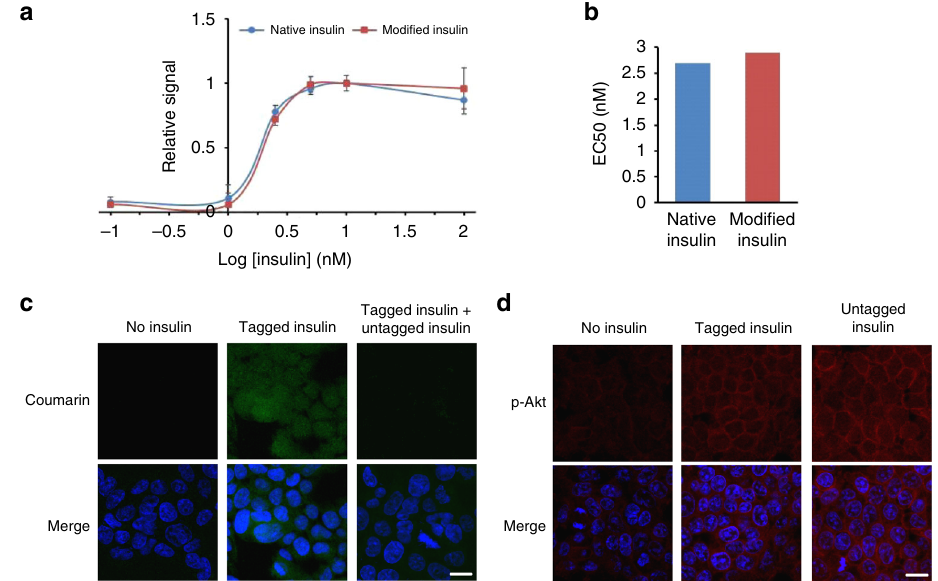
Fig. 5 Insulin bioactivity assay. a , Bioactivity measurement for native and modi fi ed insulin in a dose-dependent pAkt cell-based assay. The error bar represents standard error of mean (SEM). The assays were repeated at least three times ( n = 3). b EC50 value determination from ( a ), absolute values obtained by extrapolation of graphs in a are represented by a simple bar graph. c Uptake of tagged insulin (green) and mixture of untagged and tagged insulin in cells. Chromatin (blue). Also see, Supplementary Fig. 77. d Activation of IR signaling and pAkt (red) accumulation in HEK293T cells after insulin treatment (scale bar:10 µ m). Source data of Fig. 5 panel a provided as Source Data fi